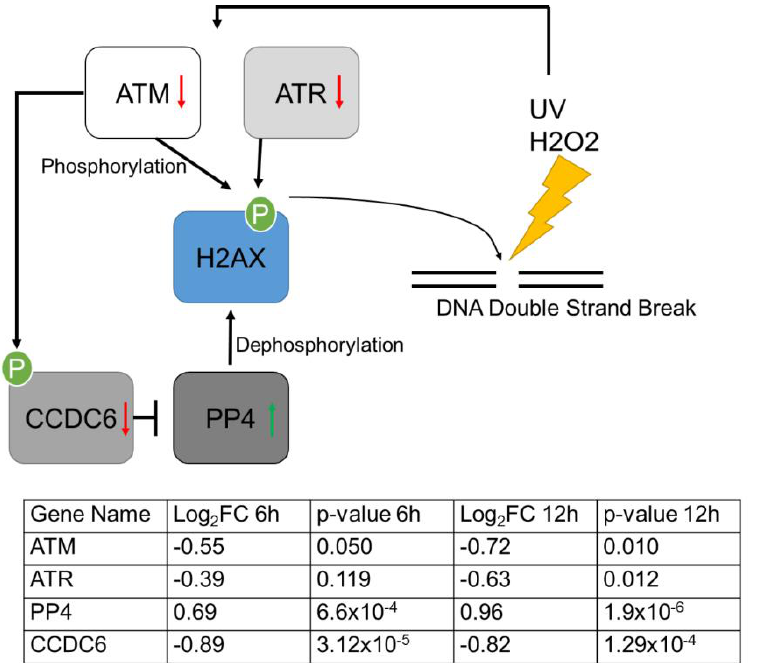
Figure 3. Gene network affected by osmotic stress regulating H2AX phosphorylation (modulated after [37]). H2AX phosphorylation is a key event during DNA damage repair. ATM and ATR phosphorylate H2AX upon DNA damage. Dephosphorylation is controlled by PP4, which is inhibited by CCDC6. Arrows indicate gene expression changes after osmotic stress. The table shows the log2 fold changes and p -values of respective genes after cultivation under osmotic stress conditions for 6 and 12 h ( n = 3).